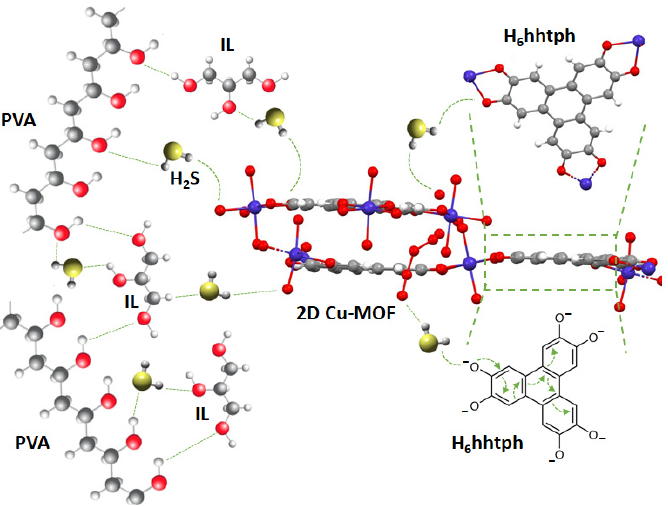
Figure 9. Illustration of the suggested H 2 S gas sensing mechanism. All atoms are color-coded; Cu: purple, O: red, C: grey, H: white, S: yellow.